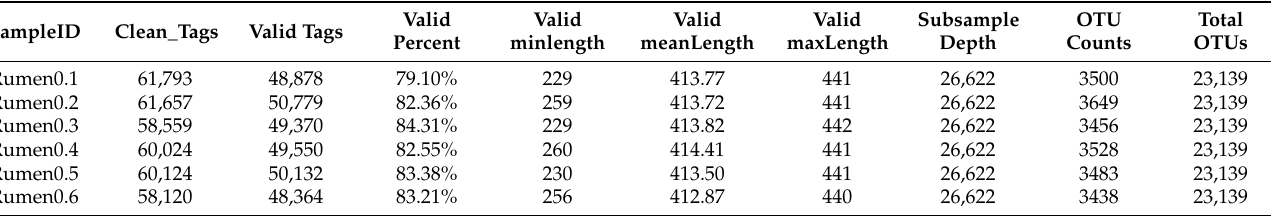
Table A1. Sample tags distribution